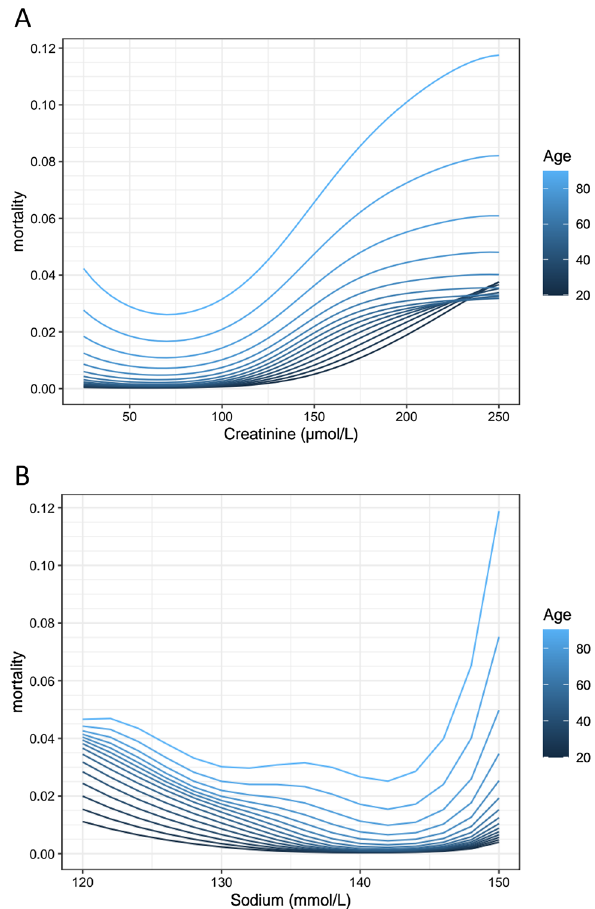
Figure 1. The associations between creatinine ( A ), sodium ( B ) and mortality and age are shown using a generalized additive logistic regression model. This model included five biomarkers and age. The four biomarkers that are not shown in the panel were left constant at ‘normal’ values. These were chosen as follows: creatinine = 80 µmol/L, leukocytes = 80 × 10^9/L, CRP = 10 mg/L, Sodium = 140 mmol/L, and hemoglobin = 9 mmol/L. Mortality is shown as mean predicted mortality risk (between 0 and